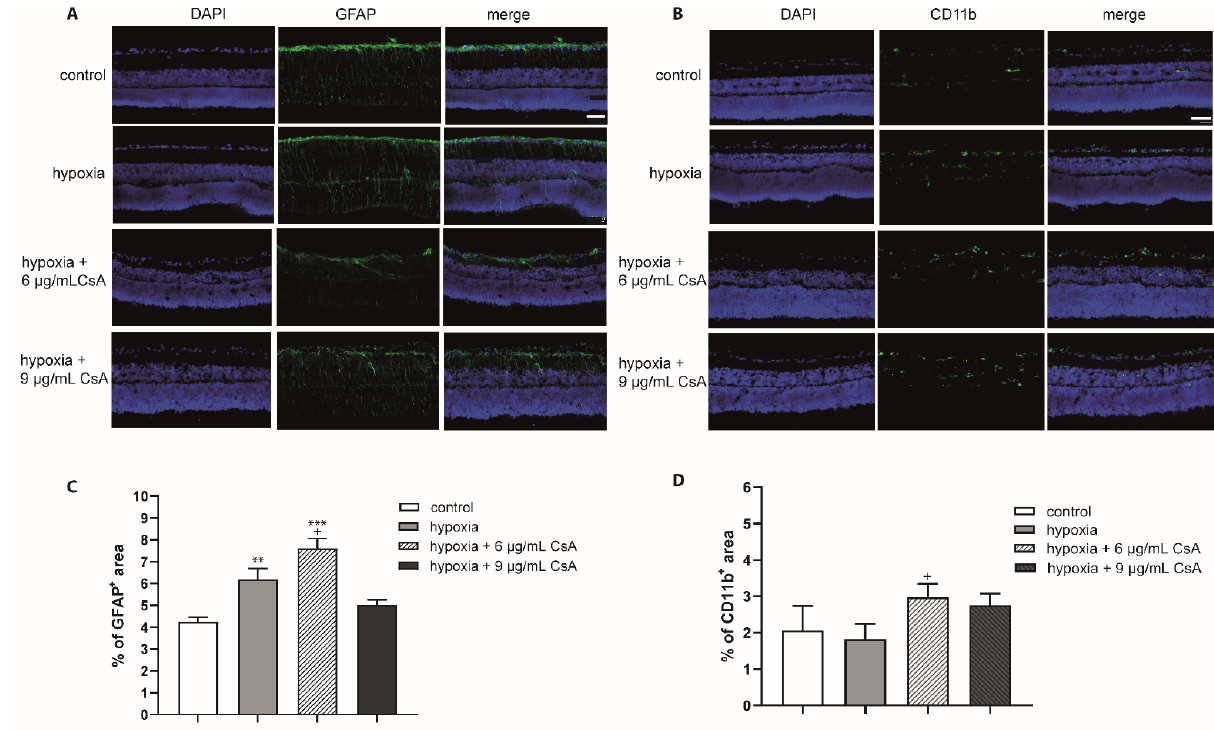
Figure 5. Effects of hypoxia and CsA treatment on glial cells. Immunohistochemical staining (GFAP and CD11b) of hypoxia- and CsA-treated retinas: representative staining of retinas cultured for 48 h. ( A ) Macroglia were labeled using a GFAP antibody (green) and cell nuclei labled with DAPI (purple); ( B ) microglia were stained with a CD11b antibody (green) and cell nuclei labeled with DAPI (purple). ( C ) The percentage of the GFAP + area compared to the total area is presented in the diagram. Scale bar indicates 30 µ m. The percentage of the macroglia area was higher than that of pure hypoxia at 6 µ g/mL CsA. The higher concentration of 9 µ g/mL CsA maintained GFAP abundance almost at the level of control retinas. ( D ) The percentage of microglia was higher in CsA-treated retinas (approximately 2.5% to 3.25%) than in controls (approximately 2%) and pure hypoxia (approximately 1.8%). Significances are indicated as * with respect to the control condition and as + with respect to hypoxia treatment using the following significance levels: + p < 0.05, ** p < 0.01, and *** p <